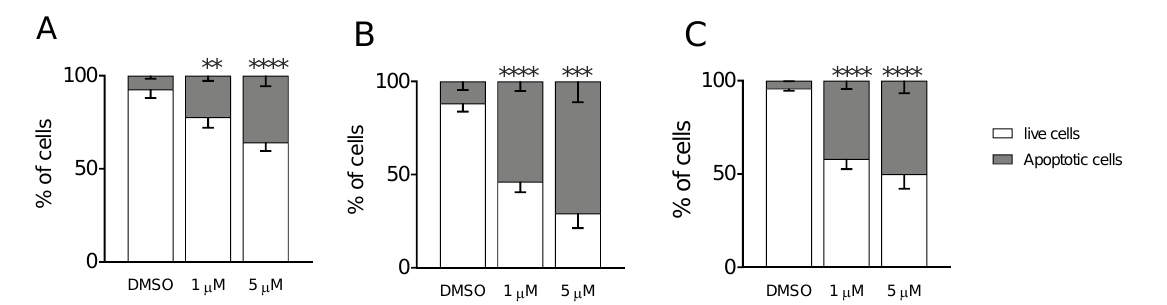
72 h Figure 9. Effect of Ff-35 on cell cycle in A549 ( A ), Hela ( B ), and MDA-MB-231 cells ( C ). Cells were treated with the compounds for 48 and 72 h, at the concentration of 1.0 µM. After this period, the cells were processed as described in the Materials and Methods section. 3.1.4. Measurement of Apoptosis by Flow Cytometry To better decipher the effect of Ff-35 on cell death, A549, HeLa, and MDA-MB-231 cells were labeled with both annexin-V-FITC and PI and then analyzed by flow cytome-